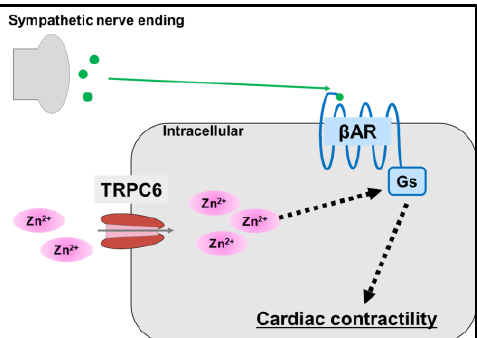
Figure 7. Zinc is involved in cardiac contractility. Schematic of the signaling pathway via TRPC6. Solid arrows represent mass transfer, dashed arrows represent signal transduction, and intracellular zinc influx via TRPC6 enhances β-adrenergic receptor (AR)-mediated Gs signaling, resulting in zinc influx via TRPC6 enhances β -adrenergic receptor (AR)-mediated Gs signaling, resulting in enhanced myocardial contractility. enhanced myocardial